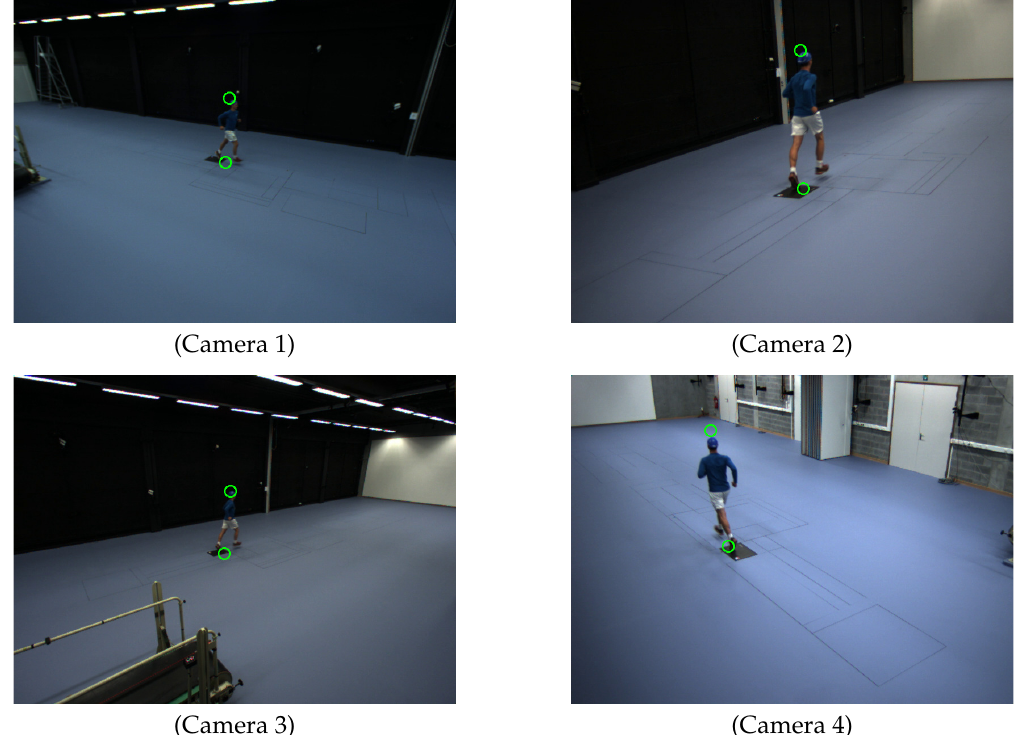
Figure 11. Detected feet and head positions of Camera Network 2. Green circles represent detected positions using ellipse fitting.